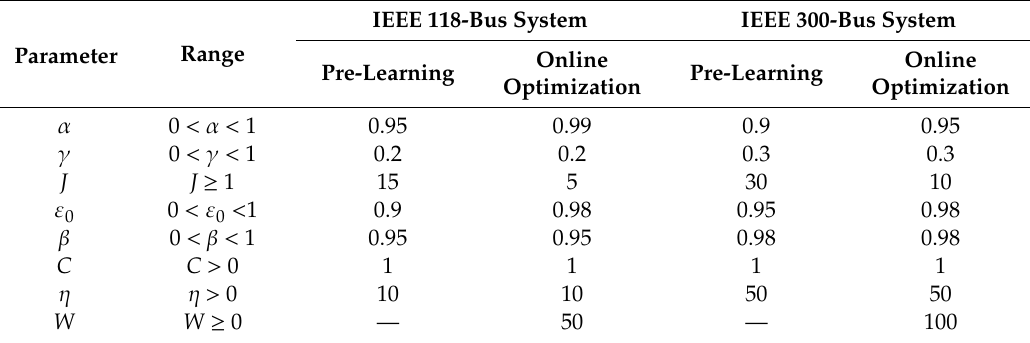
Table 1. Parameters used in